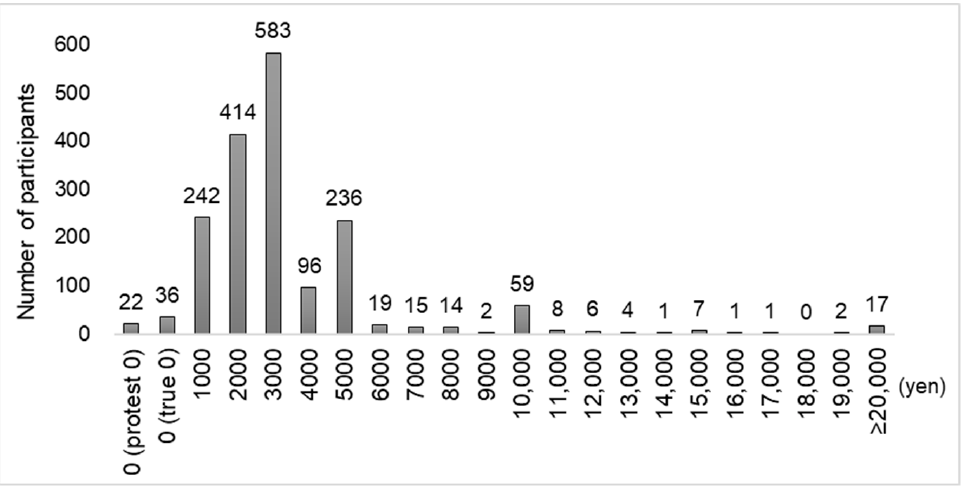
Figure 1. Distribution of WTP values for dental checkups in the RDC group.